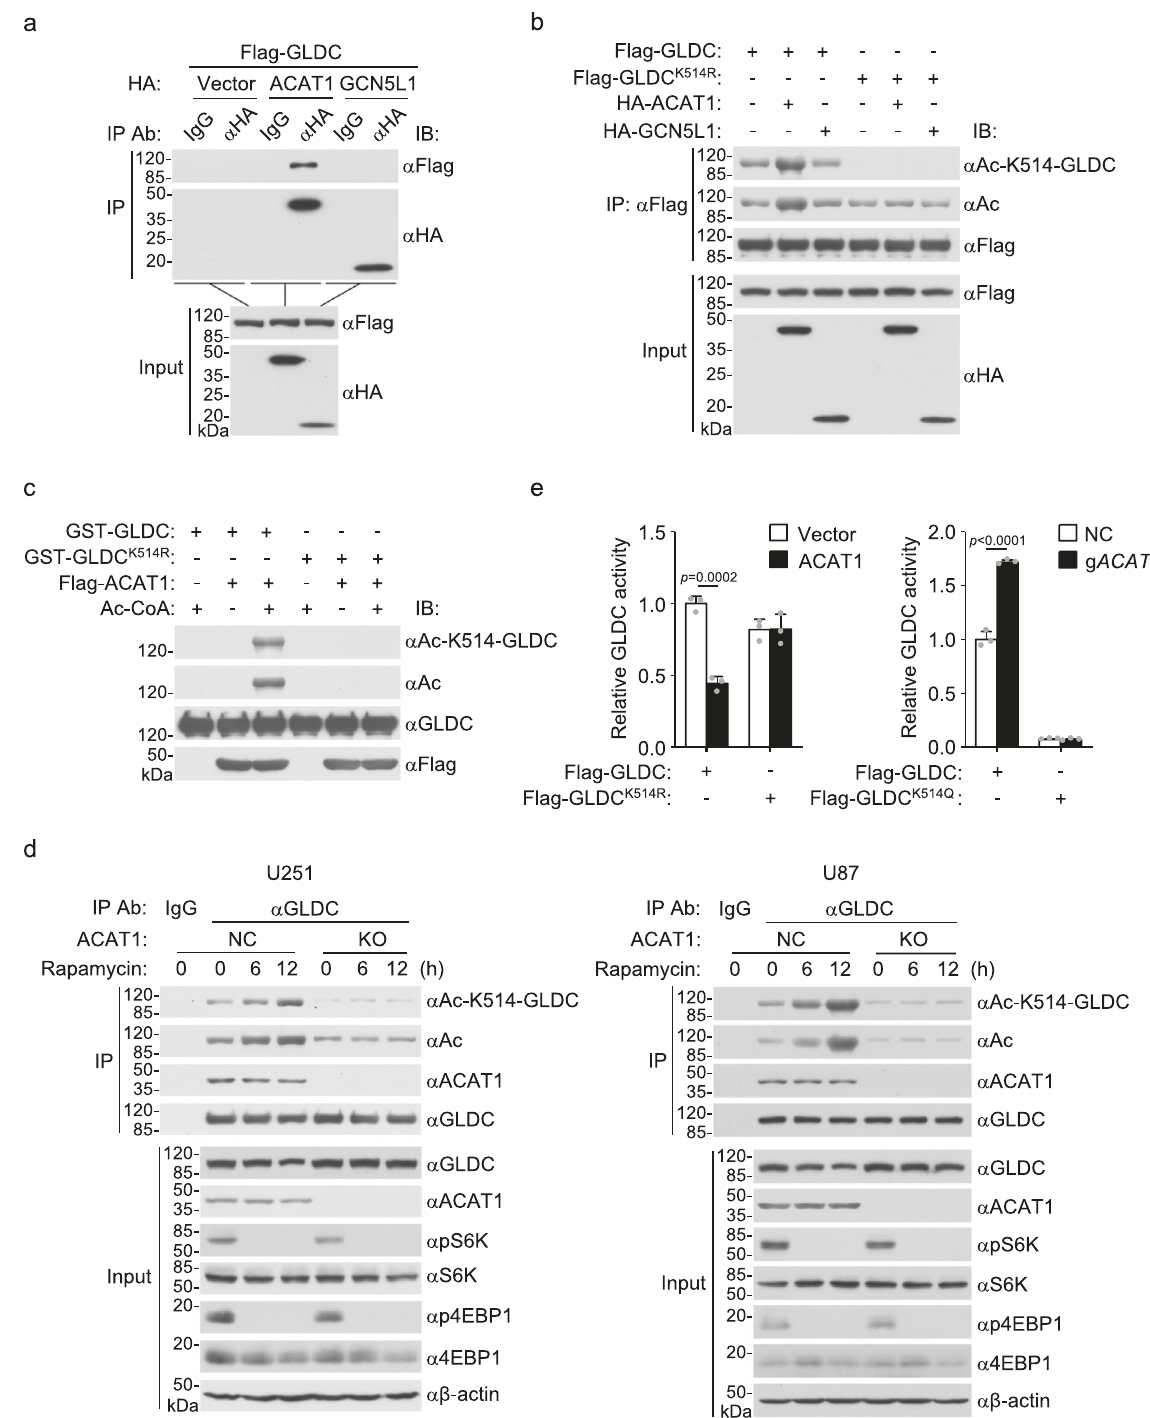
Fig. 2 ACAT1 mediates GLDC K514 acetylation. a ACAT1 is associated with GLDC. HEK293 cells were transfected with the indicated plasmids for 24 h before co-immunoprecipitation and immunoblotting analysis with the indicated antibodies. b ACAT1 mediates GLDC acetylation at K514. HEK293 cells were transfected with the indicated plasmids for 24 h before co-immunoprecipitation and immunoblotting analysis with the indicated antibodies. c Effects of ACAT1 on acetylation of wild-type GLDC or GLDC K514R in vitro. GST-GLDC was puri fi ed from E. coli . Flag-ACAT1 was puri fi ed from HEK293 cells. The puri fi ed proteins were incubated for acetylation assays, followed by immunoblotting analysis with the indicated antibodies. d ACAT1 de fi ciency inhibits Rapamycin-induced GLDC acetylation. The control or ACAT1-de fi cient U251 or U87 cells were treated with DMSO or Rapamycin (50 nM) for the indicated times before co-immunoprecipitation and immunoblotting analysis with the indicated antibodies. e Effects of ACAT1 on GLDC activity. HEK293 (left histograph) or ACAT1-de fi cient HEK293 (right histograph) cells were transfected with the indicated plasmids for 24 h before puri fi cation of Flag-GLDC, Flag-GLDC K514R , and Flag-GLDC K514Q . Equal amounts of each puri fi ed proteins (2.5 μ g) were used for GLDC activity assay. Graph shows mean ± SEM, n = 3 technical repeats. Data were analyzed using two-way ANOVA with GraphPad Prism 7. Source data are provided as a Source data fi